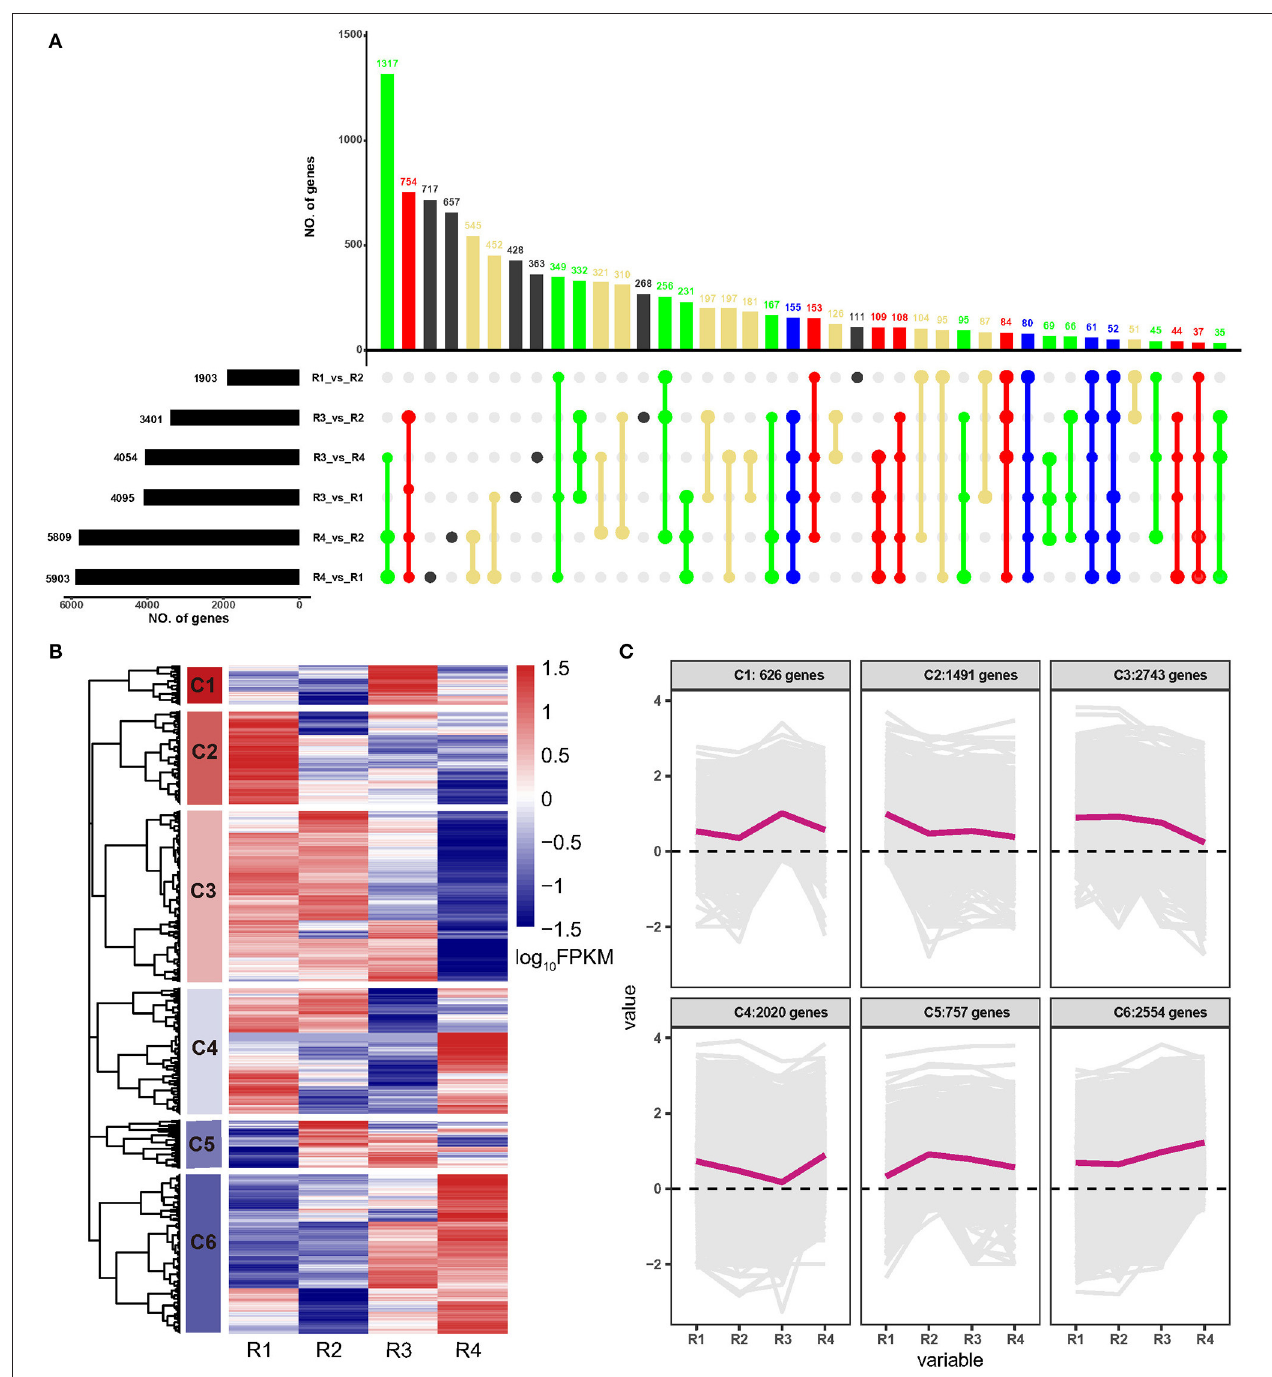
FIGURE 1 | Analyses of differentially expressed genes (DEGs) of golden buckwheat rhizomes. (A) The upset plot of the DEGs in two out of six comparisons. Black bars on the lower left represent the numbers of DEGs in comparisons R1, R2, R3, and R4. The colored bars above represent the number of common genes. Blue dots represent genes that are common in at least five of the six comparisons. Red dots represent genes that are common in at least four of the six comparisons. Green dots represent genes that are common in at least three of the six comparisons. Yellow dots represent genes that are common in at least two of the six comparisons. Black dots represent genes that are differentially regulated in only one of the six comparisons. (B) Functional category of DEGs by hierarchical cluster. (C) Expression patterns of the six clusters correspond to the hierarchical cluster result. Six main clusters are presented as C1–C6. Gene expression values are normalized to log 10